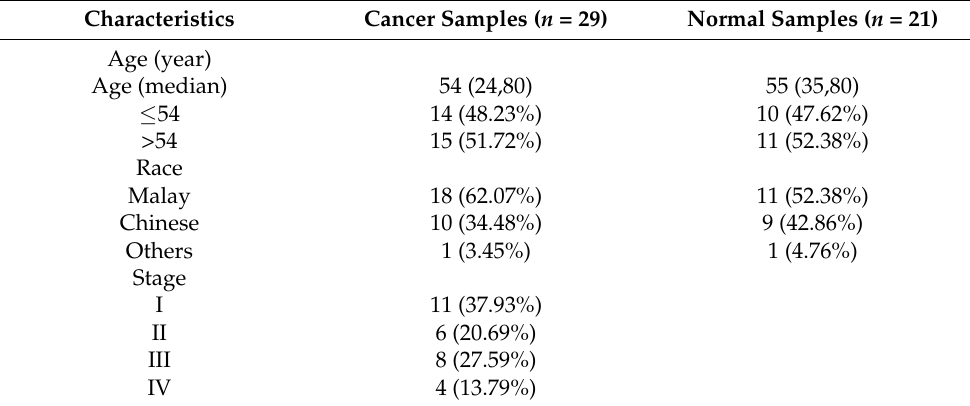
Table 3. Summary of clinical